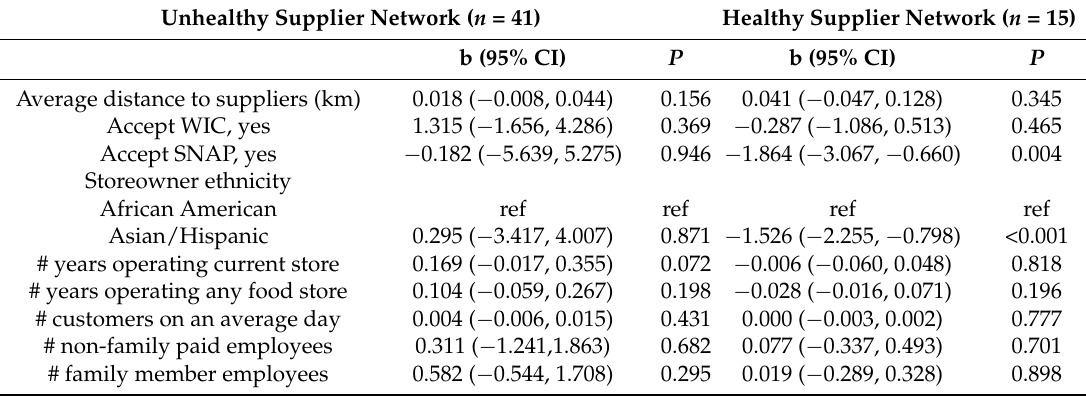
Table 3. Bivariate analyses of corner stores’ unhealthy and healthy supplier networks, outcome variable being degree